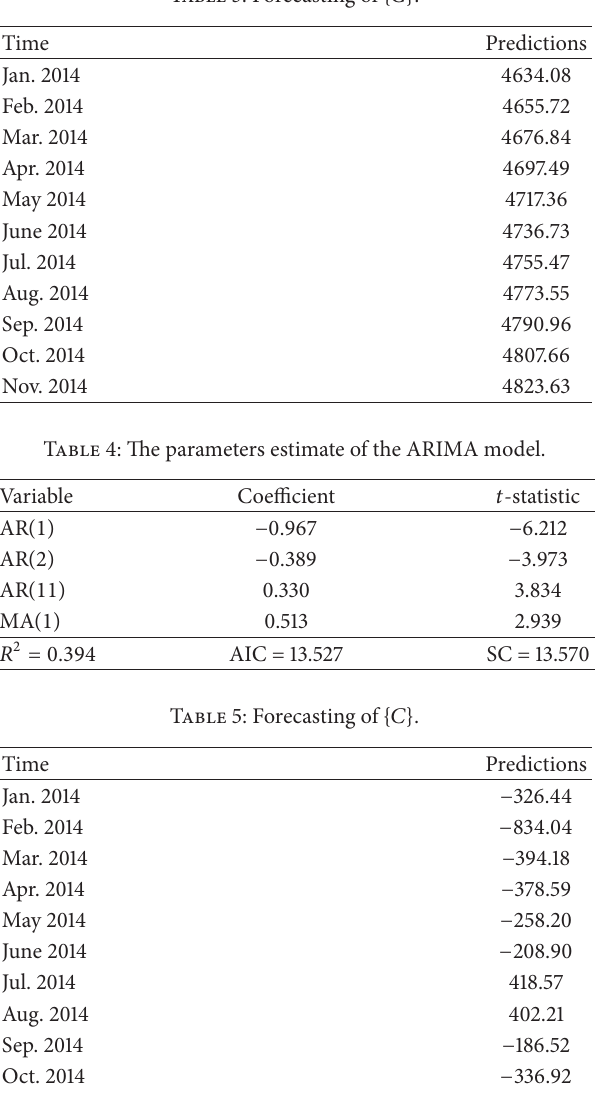
Table 3: Forecasting of {𝐺} .